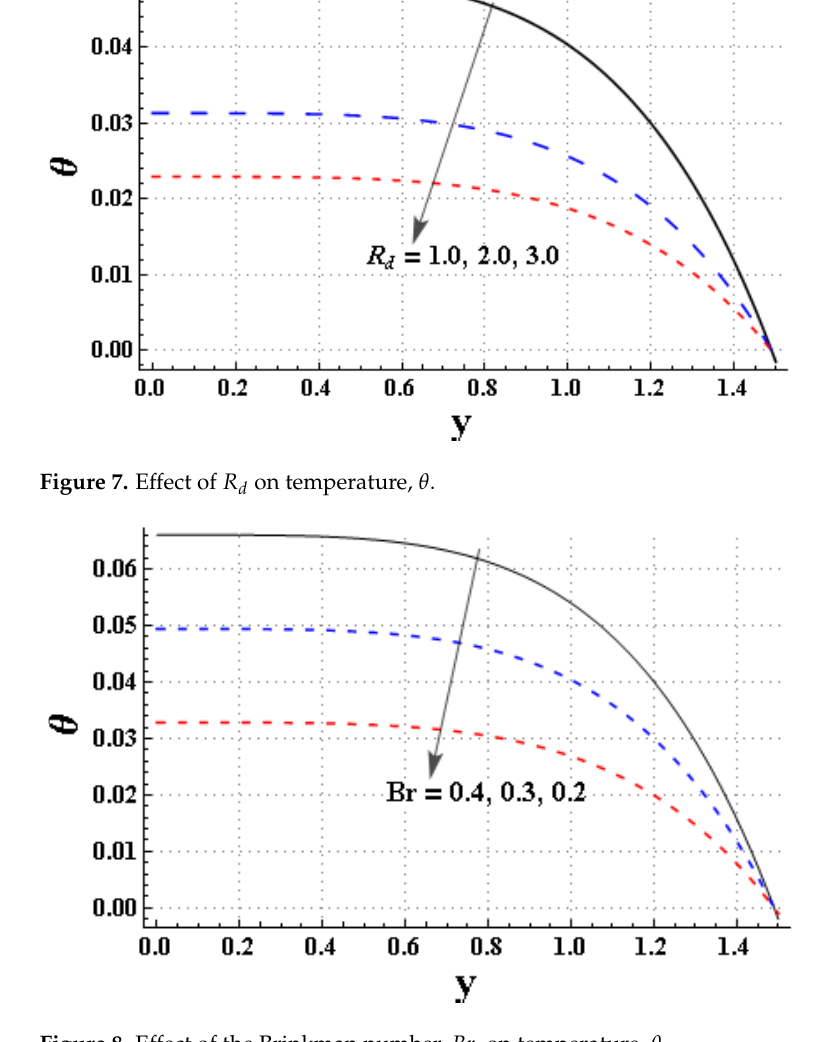
Figure 10. Effect of the temperature jump parameter, , on temperature, .